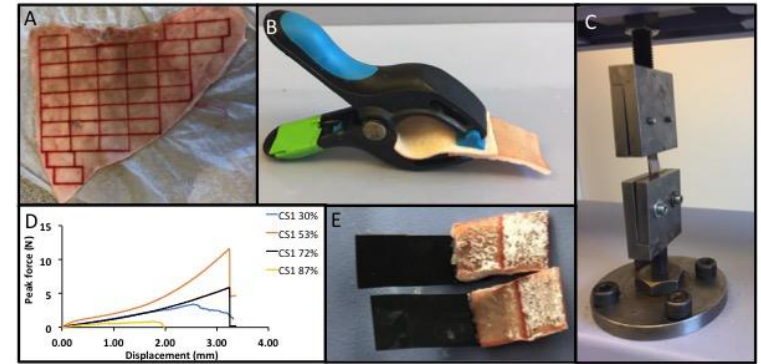
Figure 1. ( A ) Overview of the testing procedure and obtained data. Skin was removed from an entire ear, as a single piece, and subsequently sectioned into smaller strips 1 cm × 2 cm. ( B ) To ensure reproducible and comparable conditions each sample was held together during the curing stage using universal grips. ( C ) The lap shear testing setup. ( D ) Representative force / displacement curves for calcium metasilicate PMC (CS1), and the peak force per area was calculated for each sample. ( E ) Adhesive PMCs were applied to the skin surface as a viscous, tacky paste, with the failure surface.